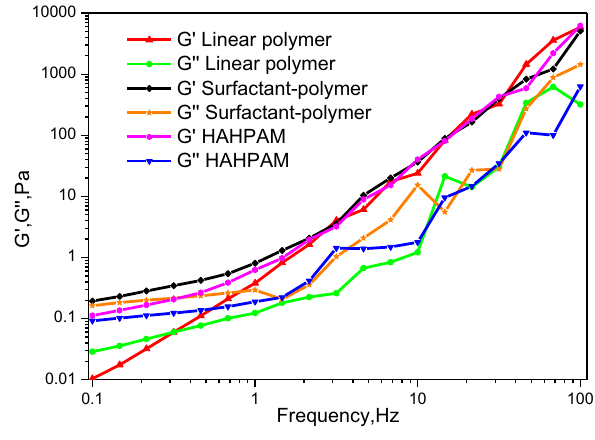
Fig. 8 Storage modulus, ( G ′ ) and viscous modulus, ( G ″ ) plot- ted as a function of frequency for HAHPAM, linear poly- mer, and surfactant–polymer in brine (salinity = 9000 mg L −1 , [Ca 2+ ] + [Mg 2+ ] = 900 mg L −1 , T = 65 °C, concentrations = 0.2